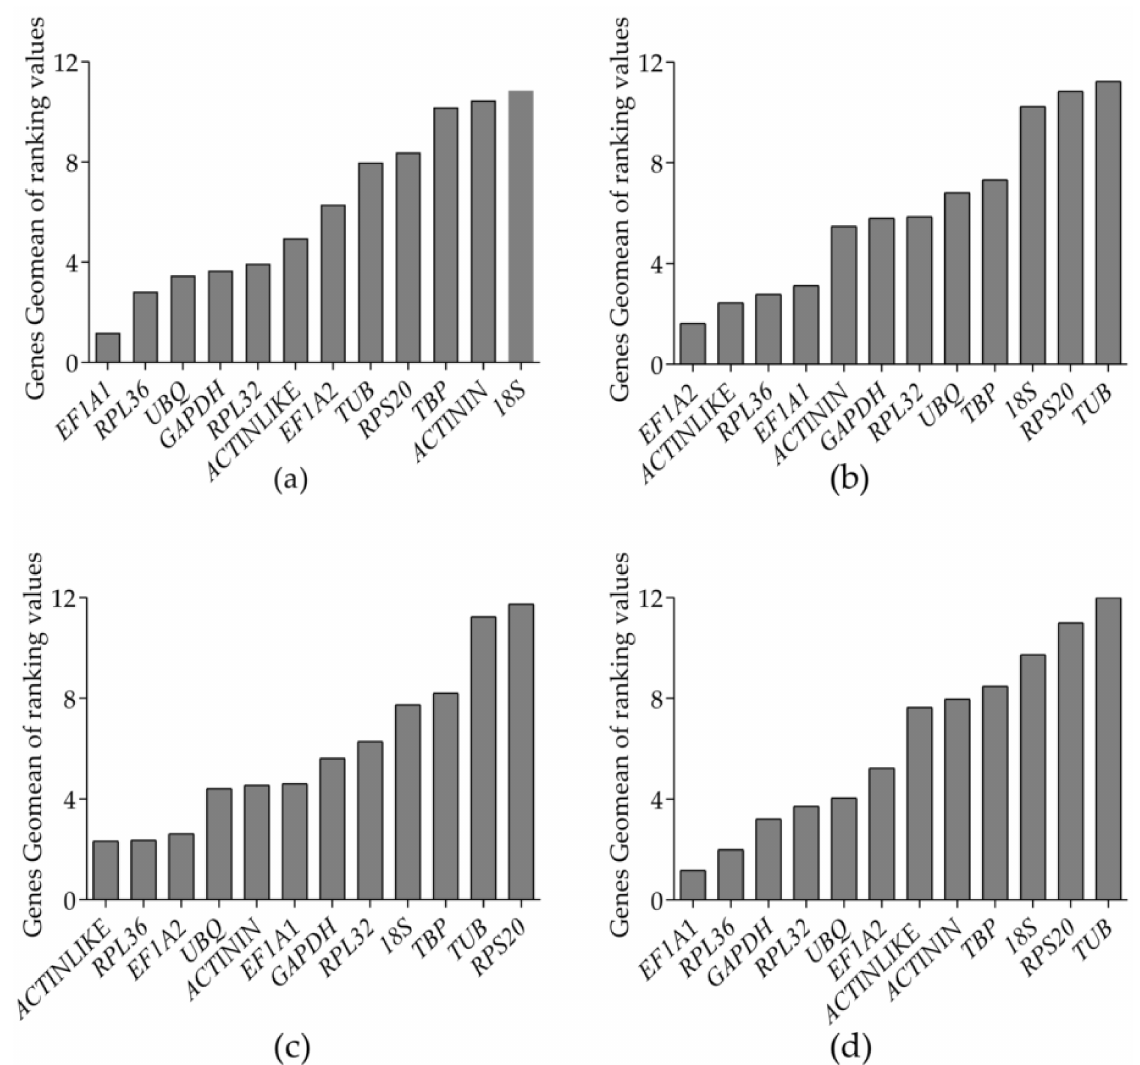
Figure 6. Stability of the expression of the candidate reference genes in Glenea cantor , as calculated by the geomean method of RefFinder: ( a ) adult tissues; ( b ) developmental stages; ( c ) sexes; and ( d ) all